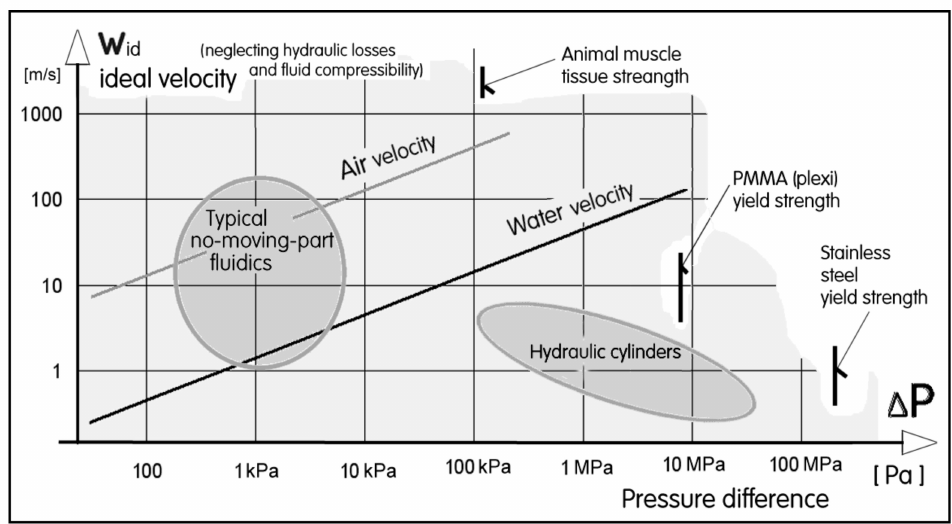
Figure 18. Pressure and velocities prevailing in a typical fluid flow channels applicable to generating the delay. Higher velocities than shown here might be generated but would result in high energy dissipation (friction and conversion into heat). Other limits are stresses in the device body that may endanger its life and reliability.